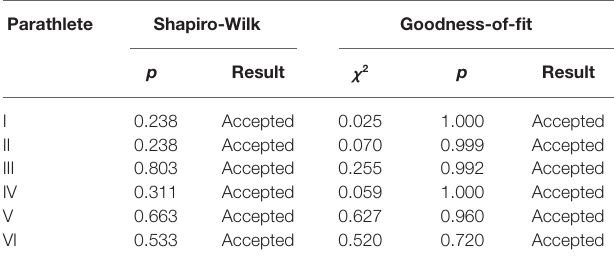
TABLE 4 | Normality tests and goodness-of-fit for the linear regression for MVIC ( Y ) marker as a function of time ( X ). Parathlete